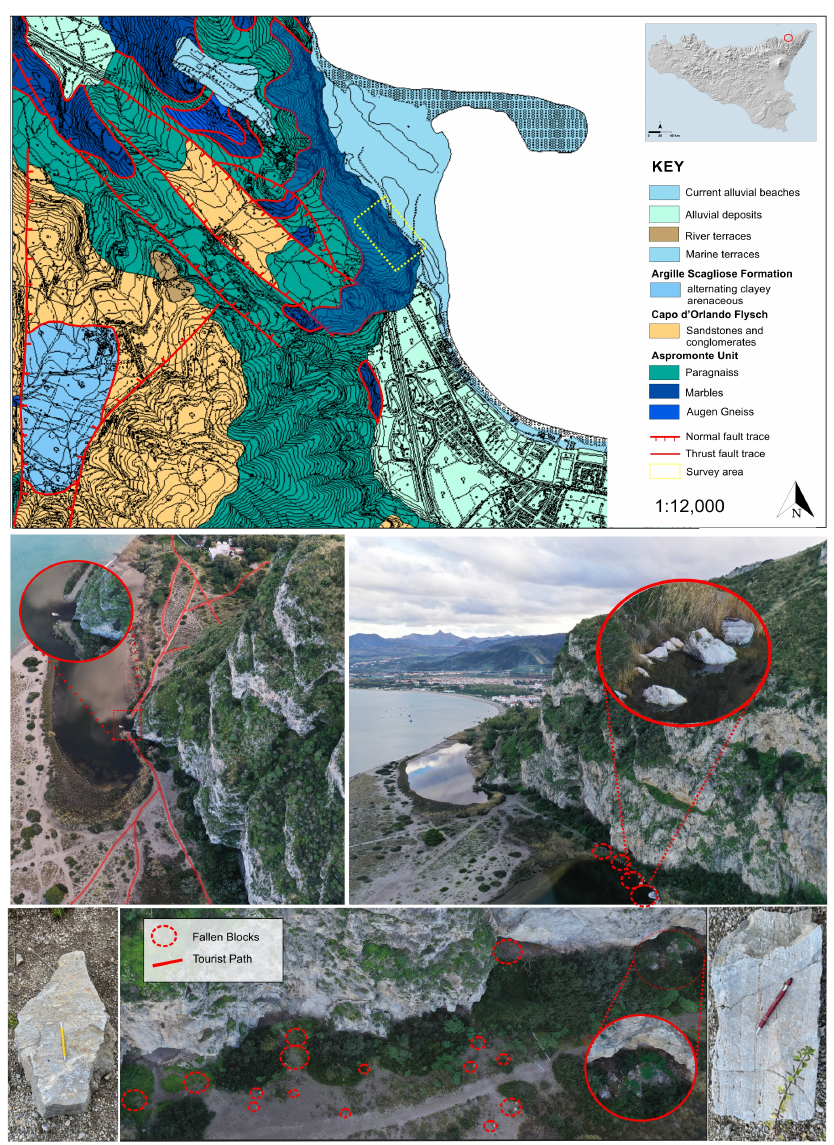
Figure 1. Geological map and aerial photos of the study area also showing the presence of tourist paths and widespread previously fallen